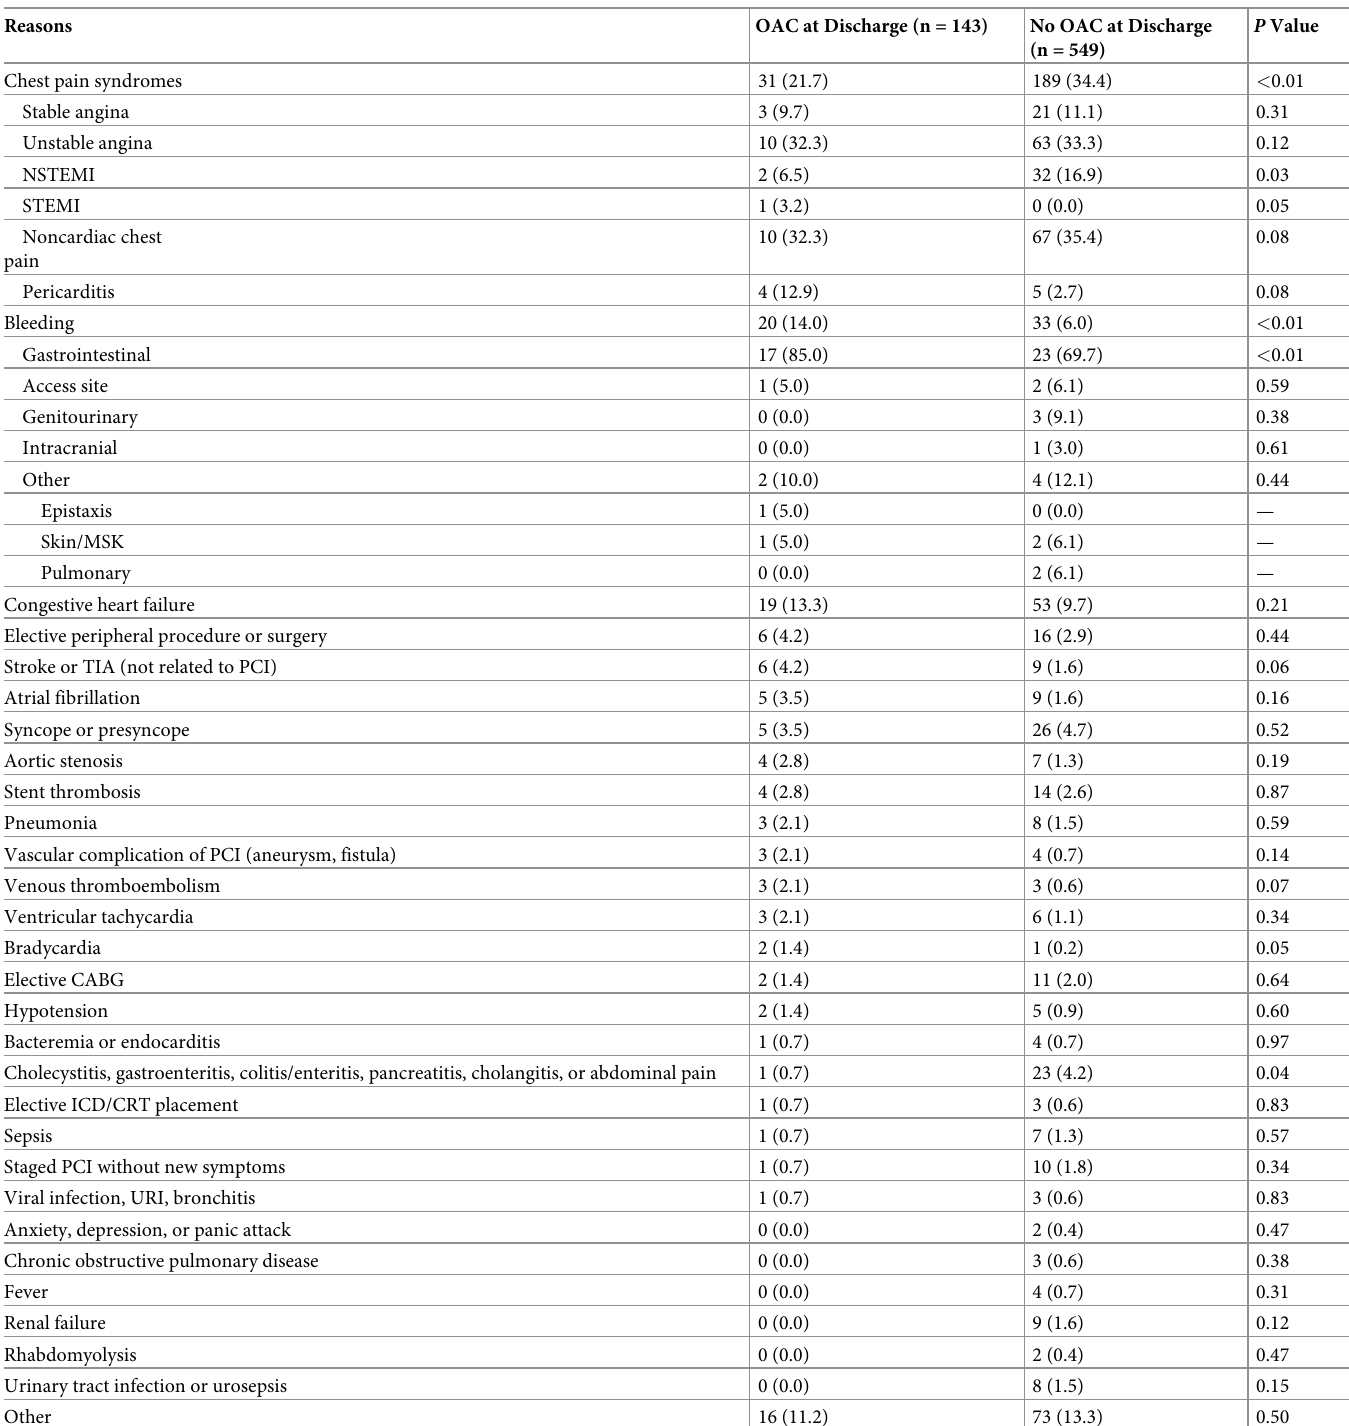
Table 3. Reasons for 30-day